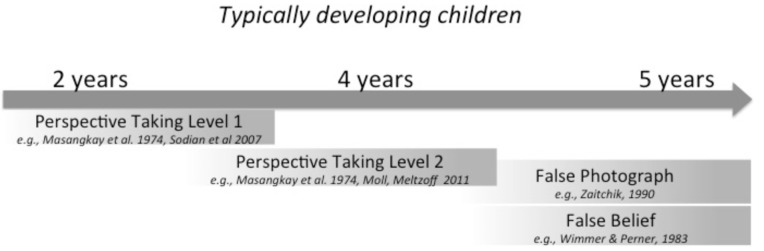
Development of precursor abilities to False Belief along a Theory of Mind (ToM) developmental trajectory in typically developing, hearing children. In these studies, perceptual experience, language experience, social experience, and biological maturation are tightly intertwined (e.g., Bigelow and Dugas, 2009), and continues to be intertwined as ToM develops into adulthood, for instance, in the use of figurative language such as sarcasm (e.g., Happé, 1994; O’Reilly et al., 2014). Our goal in the present paper is to determine which, if any, of these precursor abilities can develop on the basis of visual experience alone (i.e., which are robust given a lack of access to language and the richer social experiences afforded by language).